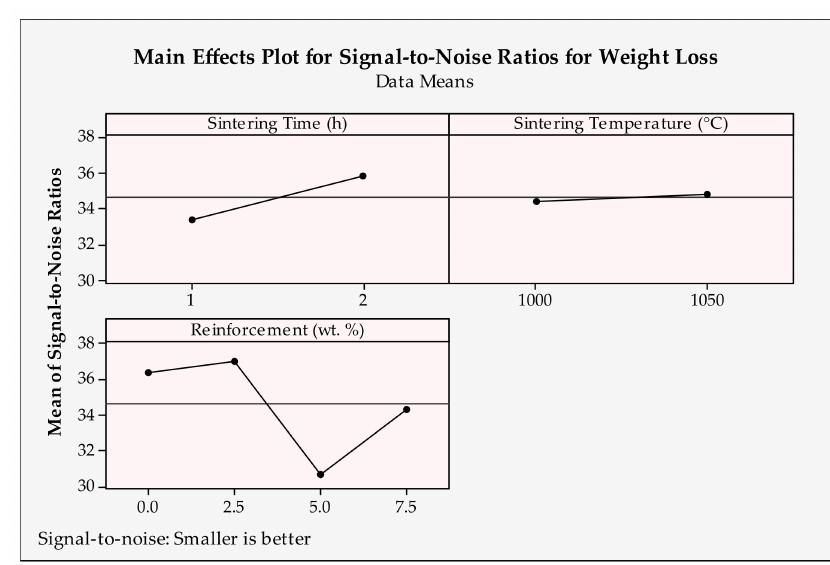
Figure 12. Signal-to-noise ratios of weight loss for production parameters.